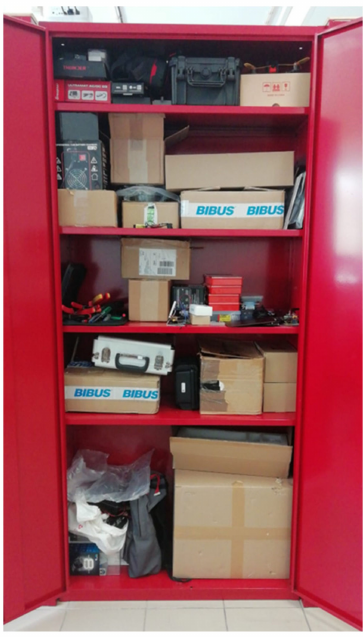
Figure 3. Cabinet before the implementation of Lean tools.